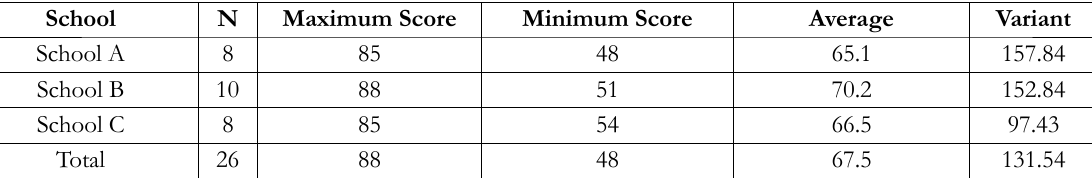
Table 6. Student’s Geometry Understanding Test Results